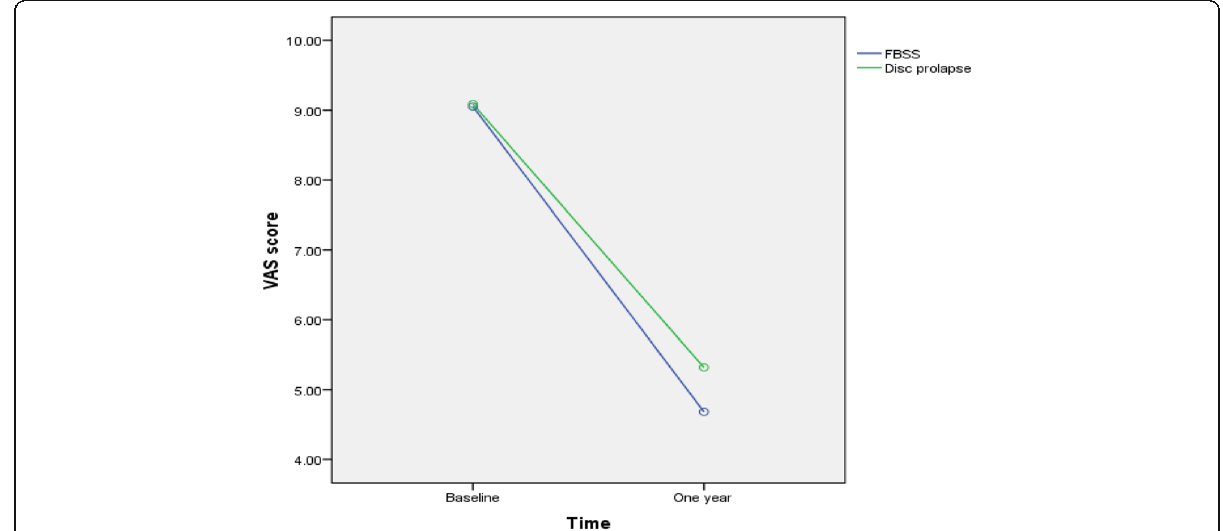
Fig. 2 Improvement in VAS score over time in patients with FBSS and disc prolapse. VAS, visual analog scale; FBSS, failed back surgery